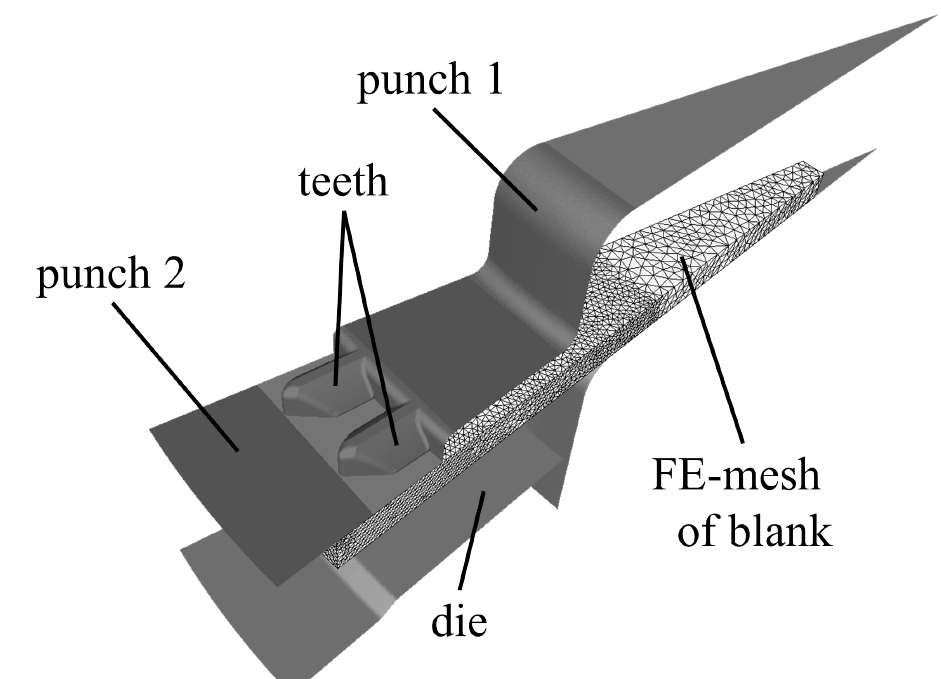
Figure 12. The FEA-model of the simulated use case manufacturing process “deep